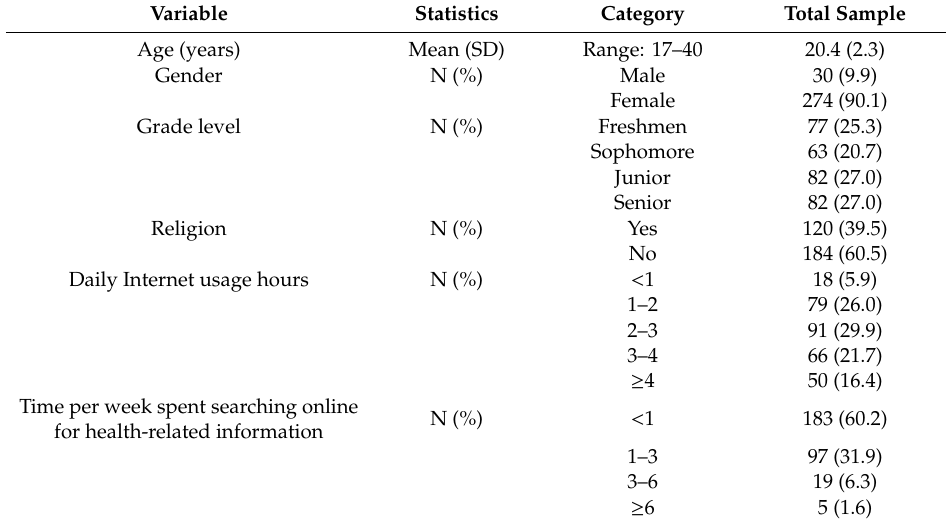
Table 1. Subjects’ general characteristics (N =